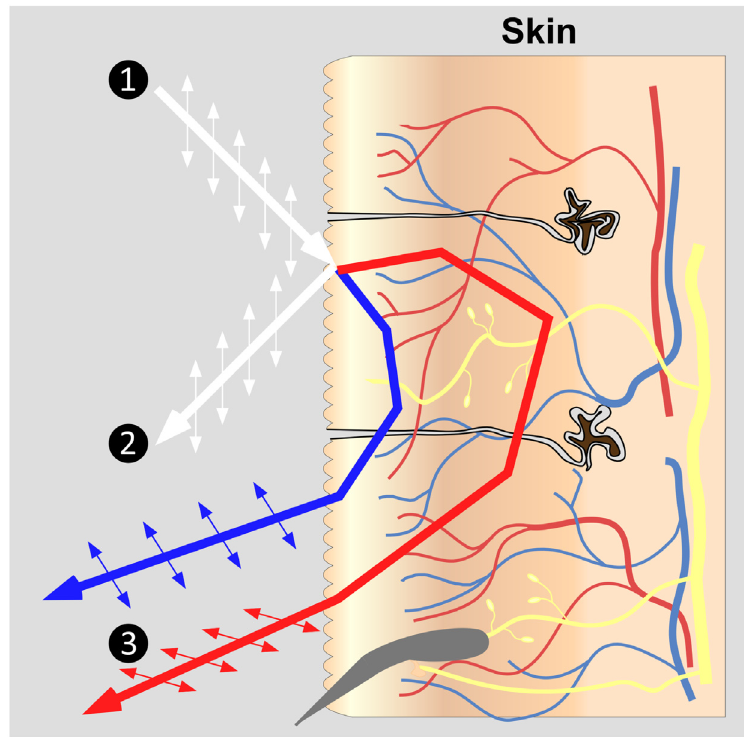
Figure 6. Light-tissue